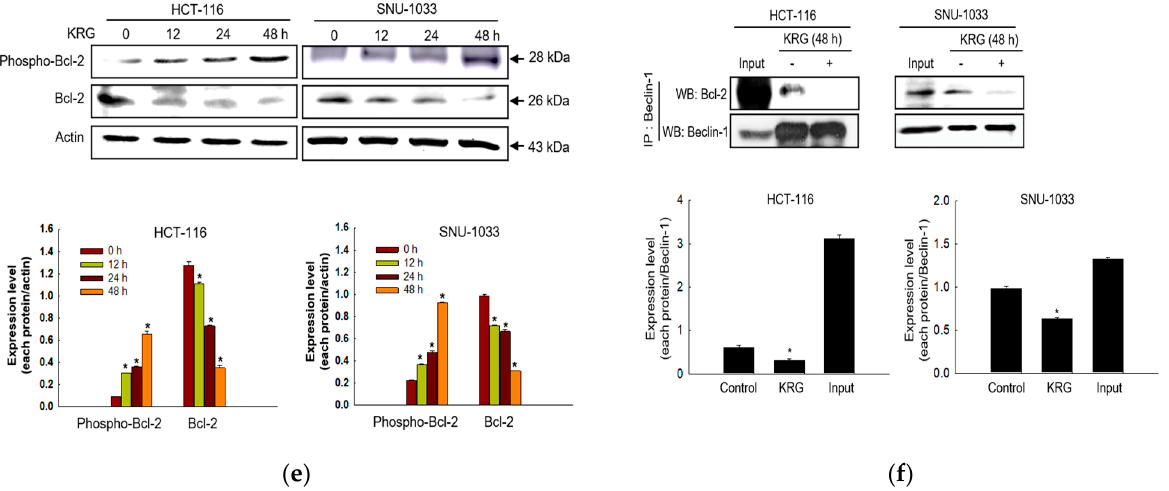
Figure 3. KRG extract induces apoptosis. The KRG extract-treated cells were incubated for 48 h or for the indicated durations. ( a ) The formation of apoptotic cells was assessed and quantified after staining of the cells with Hoechst 33342. Apoptotic cells are indicated by arrows. Scale bar, 10 µ m. * p < 0.05 vs. untreated control. ( b ) Apoptotic sub-G 1 DNA content was detected and quantified using flow cytometry after PI staining. * p < 0.05 vs. untreated control. ( c ) Active (cleaved) caspase-9 (35 and 37 kDa), caspase-3 (17 and 19 kDa), and PARP1 (89 kDa) levels were assessed using western blot analysis. * p < 0.05 vs. 0 h group. ( d ) Cells were incubated with the KRG extract (2.0 mg/mL in HCT-116; 2.3 mg/mL in SNU-1033) in the absence or presence of z-VAD-FMK (5 µ M) for 48 h, and cell viability was assessed using the MTT assay. * p < 0.05 vs. control; ** p < 0.05 vs. the KRG extract-treated cells. ( e ) Bcl-2 and phospho-Bcl-2 levels were assessed using western blot analysis. * p < 0.05 vs. 0 h group. ( f ) Cell lysates were subjected to immunoprecipitation with an antibody against Beclin-1, and western blot analysis was performed with an antibody against Bcl-2. Input is the whole cell lysate and the untreated group is the immunoprecipitate of the cell lysate with Beclin-1 antibody. * p < 0.05 vs. untreated